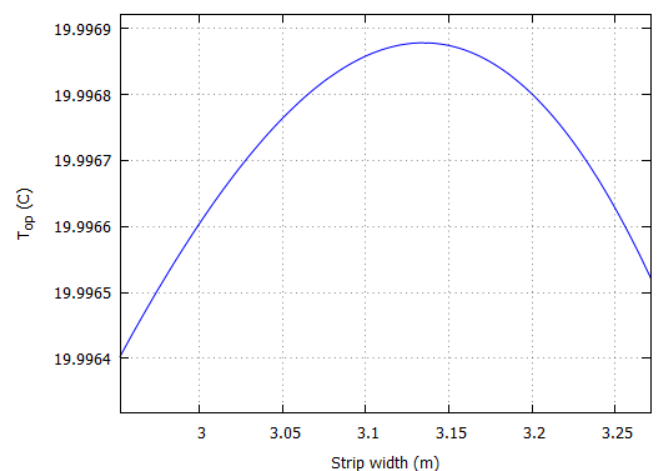
Figure 22. Operative temperature maximum for a heated strip on the